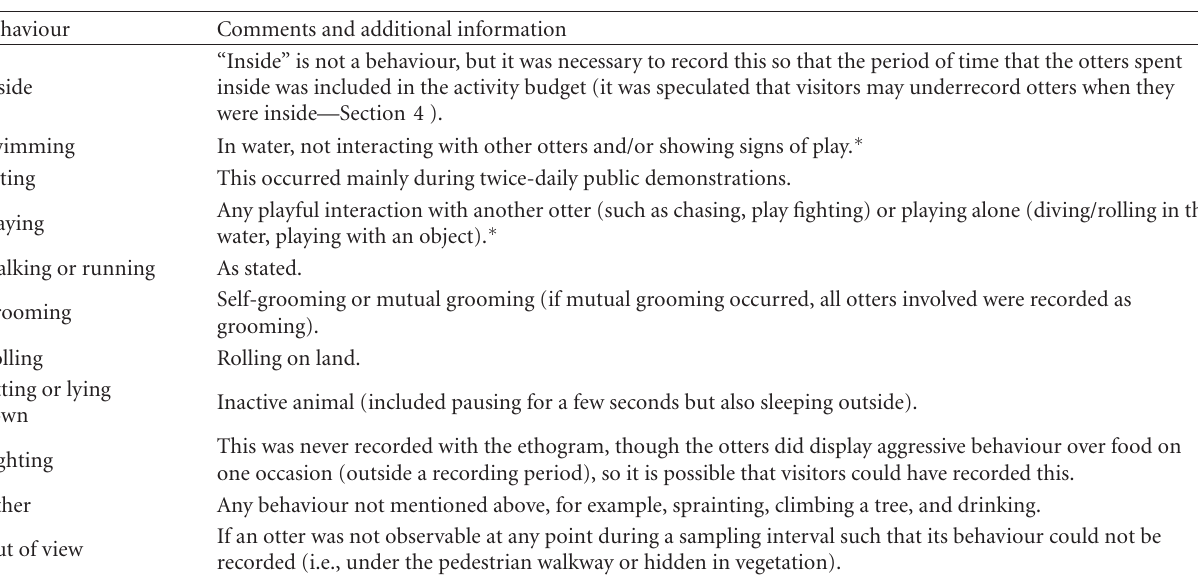
Table 1: Ethogram used by a trained biologist to record simple otter behaviours.